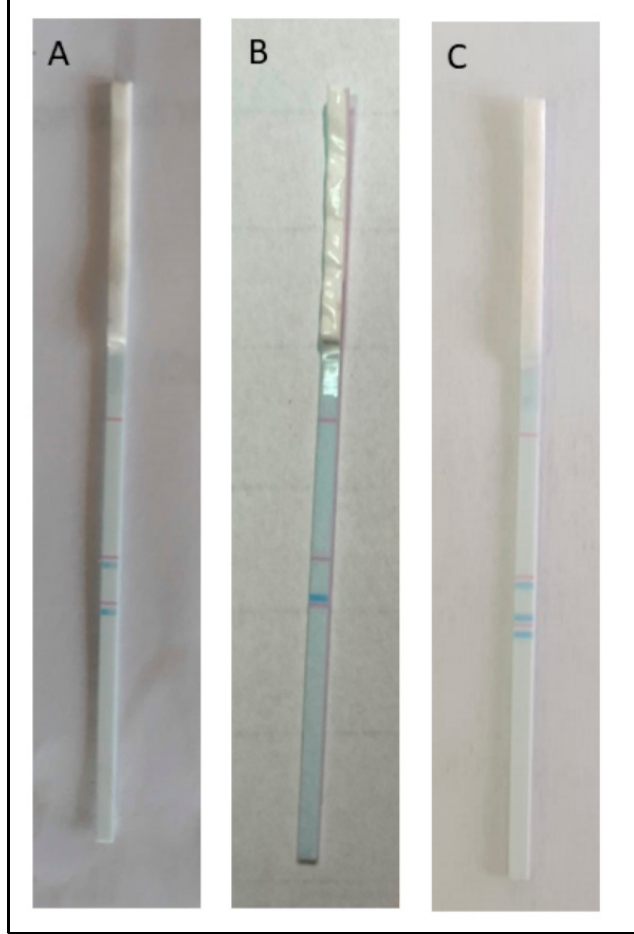
Figure 4. The developed multiplex polymerase reaction (mPCR)-based DNA lateral flow assay (MBDLFA) was specific and successfully detected: ( A ) nuc and mec A from genomic DNA extracted from Staphylococcus aureus S31; ( B ) van A/B from genomic DNA extracted from Enterococcus faecalis E25; and ( C ) nuc , mec A, and van A/B from pooled genomic DNA of S31 and E25, using the designed chromatography-printed assay strip (C-PAS). The red lines on the strip represent position markers that help localization of the test lines.